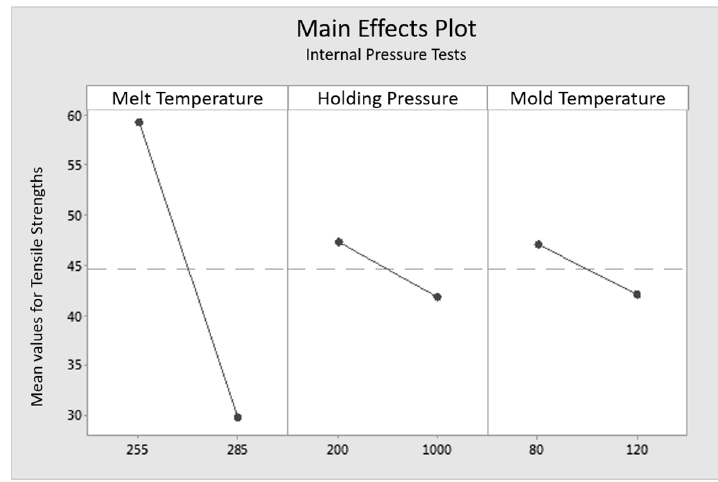
Figure 15. Main effects plot of tensile tests for the influencing factors “mass temperature”, “holding pressure” and “mold temperature” on the tensile load perpendicular to the fiber orientation.